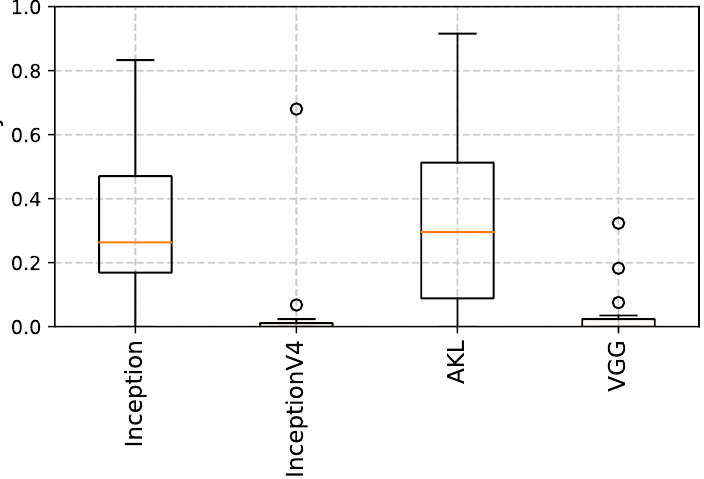
256. 256. 256. ˆ × ˆ